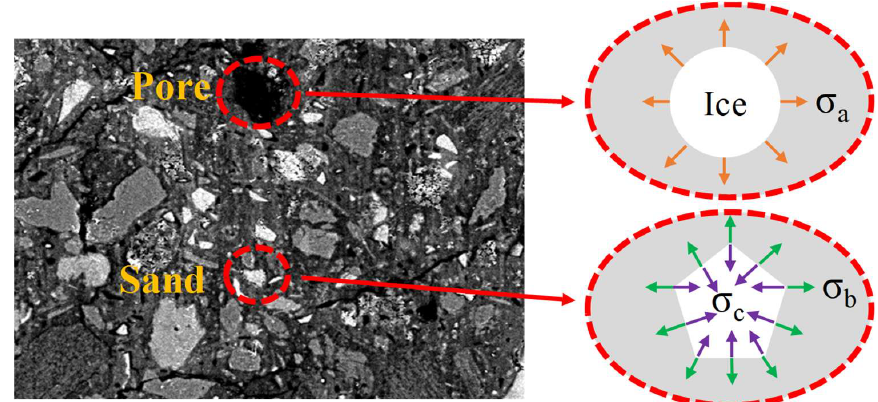
Figure 10. Schematic diagram of freeze–thaw damage mechanism.